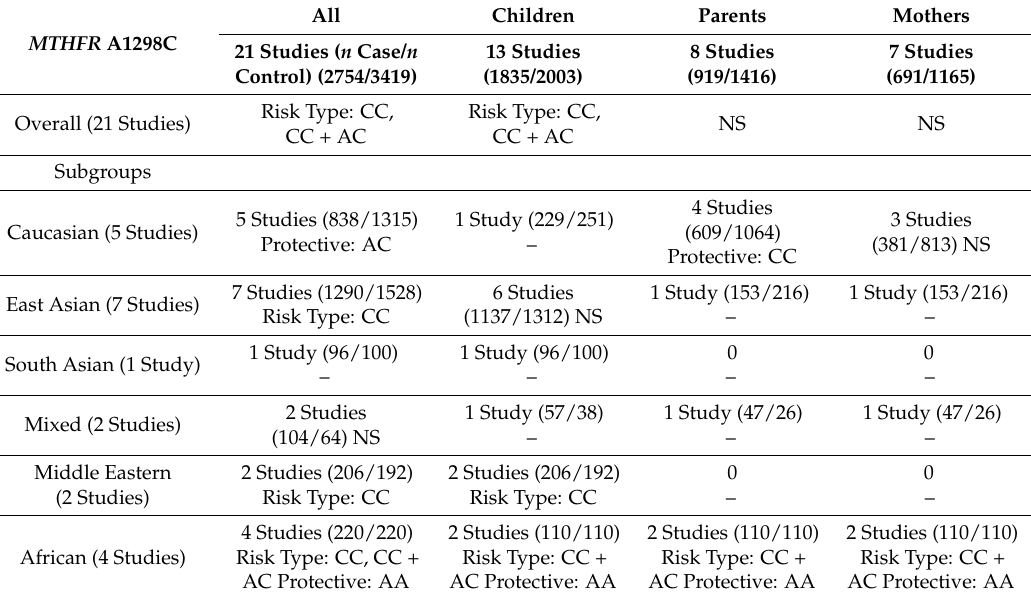
Table 3. Schema of significant findings across studies on MTHFR 1298 genotypes and risk of congenital heart diseases